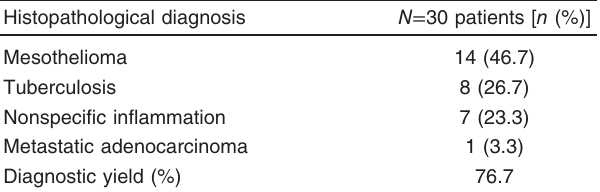
Table 4 Cryobiopsy histopathological results among studied group Histopathological